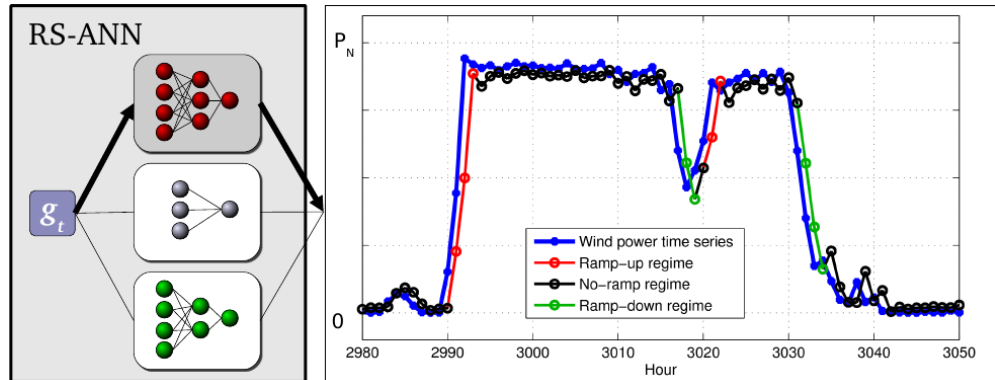
Figure 2. RS-ANN model (left). One-hour ahead forecasting (right). The architecture of each ANN was optimized for each prediction horizon considered.